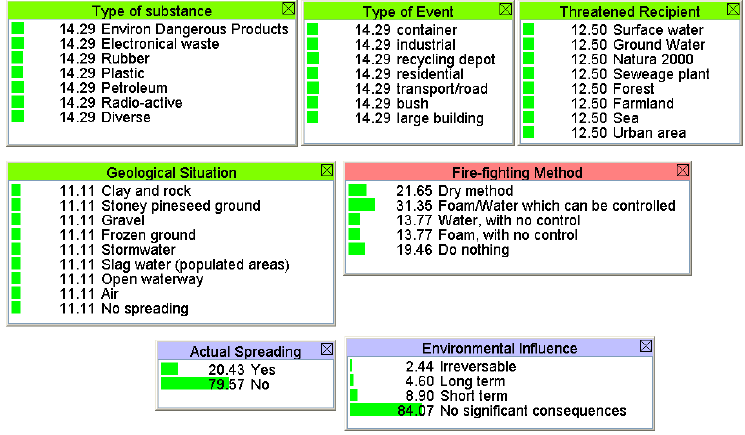
Figure 9: Quantified BN for the environmental impact of different fire-fighting